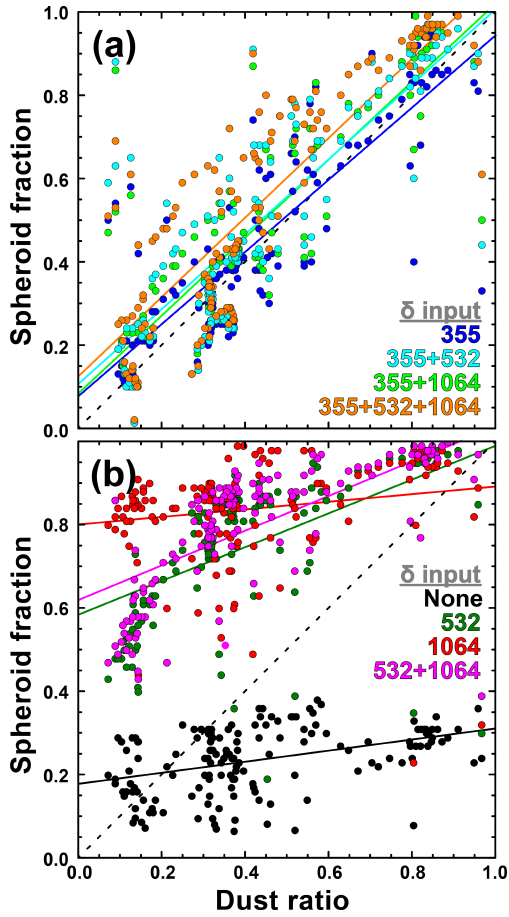
Figure 7. Connection between the retrieved spheroid fraction (from inversion) and the ratio of non-spherical particles to the 532nm backscatter coefficient (from lidar measurements of δ 532 ) for the input data sets listed in Table 2 and the cases listed in Table